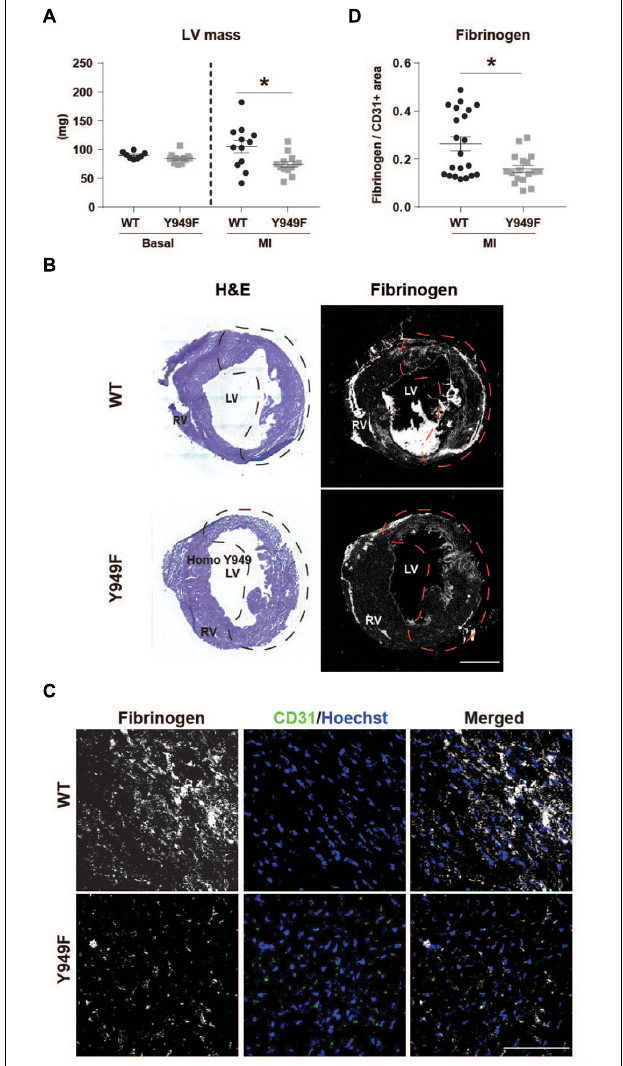
FIGURE 2 | Reduced edema and fibrinogen leakage in Vegfr2 Y 949 F / Y 949 F MI hearts. (A) Left ventricular (LV) wall mass (mg) in WT and Vegfr2 Y 949 F / Y 949 F hearts at baseline condition ( n = 8–11 mice/strain) and 24 h after MI ( n = 12–13 mice/strain). Mann–Whitney test, * p < 0.05. (B) Hematoxylin/Eosin (H&E) and fibrinogen immunofluorescent staining on total WT (top) or Y949F (bottom) heart sections. Scale bar, 1500 µ m. The infarct area detected using echocardiography, is indicated by stippled lines in black or red. (C) Fibrinogen (gray) and CD31 (green) immunofluorescent staining of WT and Vegfr2 Y 949 F / Y 949 F hearts at 3 days after MI; sections from the infarcted area. Scale bar, 100 µ m. Hoechst (blue) shows nuclei. (D) Quantification of fibrinogen area normalized to CD31 area in randomly selected regions in total WT and Vegfr2 Y 949 F / Y 949 F hearts at 3 days after MI ( n = 17–21 fields/section from 6 to 7 individual hearts/strain and 2–3 sections/heart). Mann–Whitney test, * p < 0.05. For all panels, n refers to biological